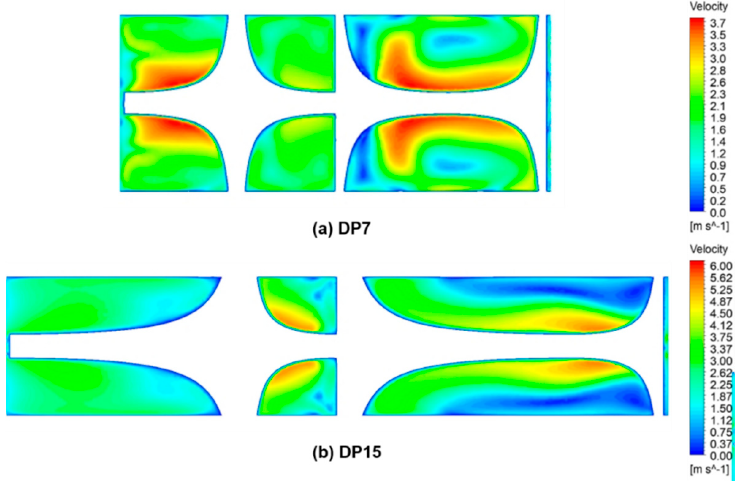
Figure 12. The velocity field of the axial cross-sections of the two design points: ( a ) DP7 and ( b ) DP15. Figure 13 shows the streamline after combining two adjacent elements of DP7 and DP15, and it can be seen that DP7 with a shorter aspect ratio had a more distorted flow. By analyzing the axial interface, we obtained that the essence of changing the centrosymmetric position was the combination of two elements with different aspect ratios at θ = 90 ◦